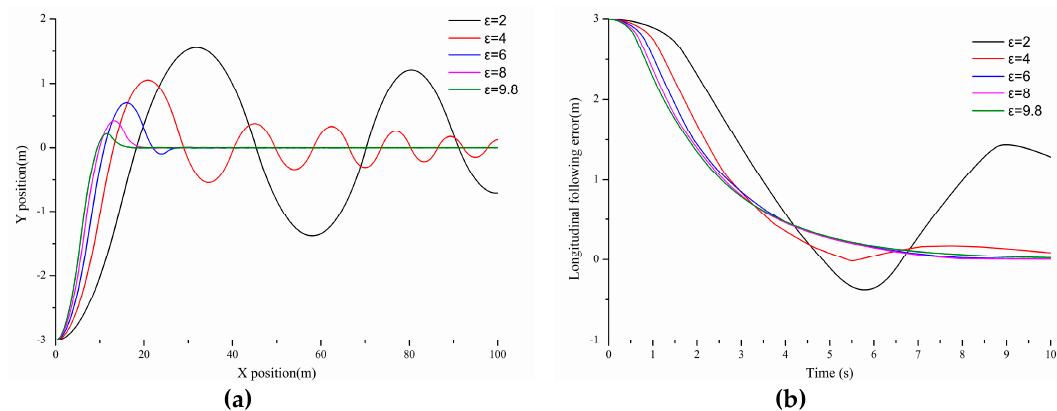
Figure 4. Particle motion under the different values of ε : ( a ) The path of particle model in the global coordinate system under the different values of ε ; and, ( b ) The longitudinal following error of particle model under the different values of ε .